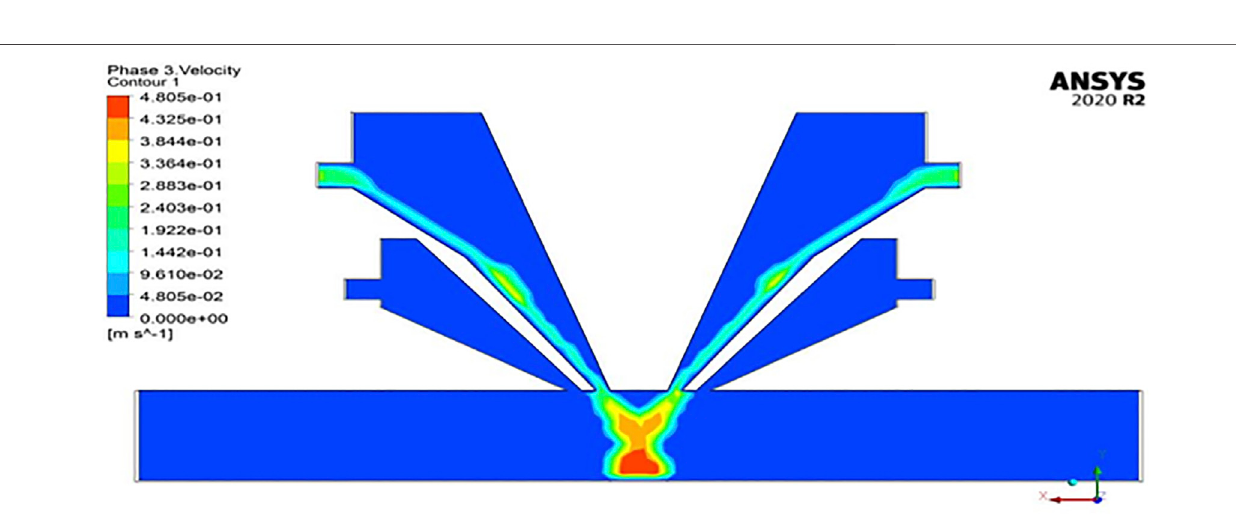
FIGURE 12 | Particle velocity pro fi le: Ar as carrier gas and He as shielding